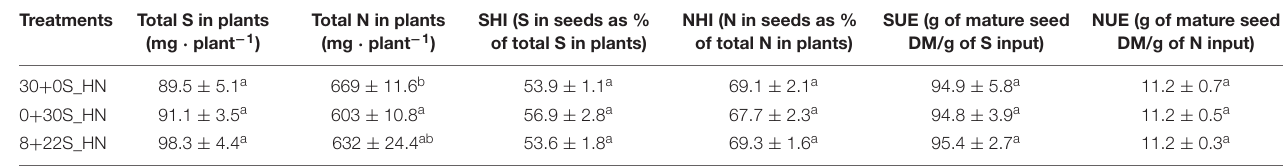
The values correspond to the mean ± SE (n = 5). Different letters indicate that mean values are significantly different (p < 0.05).